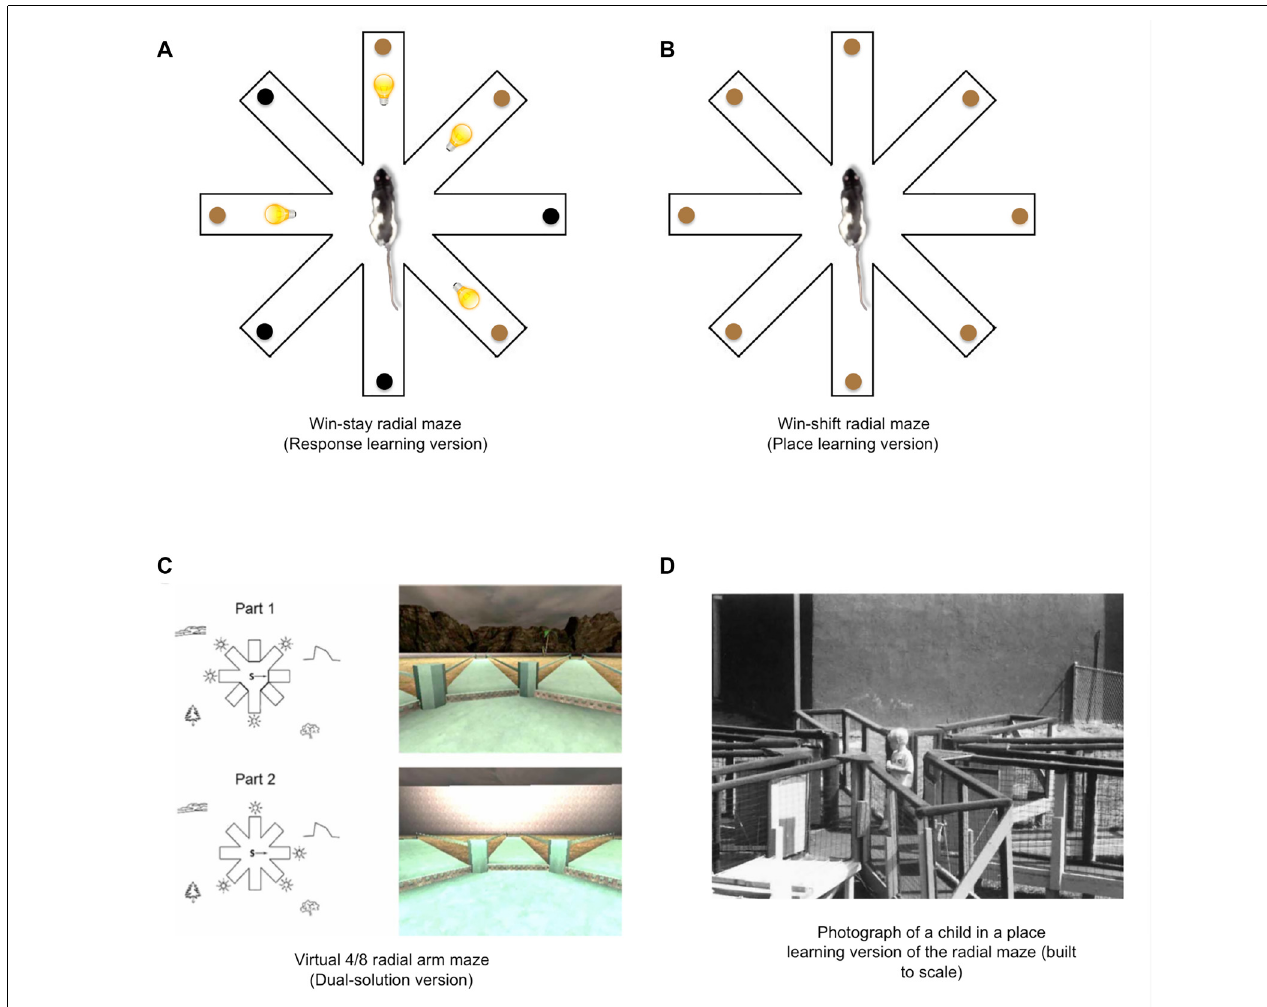
FIGURE 5 | Place and response learning in the eight-arm radial maze. (A) In the “win-stay” radial maze task, light cues signal whether food is available at the end of each arm. This task promotes S-R response learning to the extent that the light cues (S) become associated with approach behavior (R). (B) In the win-shift radial maze, a rat must employ extra-maze spatial cues to locate food and avoid re-entries into arms in which food was already retrieved, thus promoting the use of place learning. (C) A virtual 4/8 dual-solution version of the radial maze may be employed to examine the relative use of place and response learning in human subjects. Each trial of this task is divided into two parts (Part 1 and Part 2). During Part 1, four of the eight arms are blocked with a wall, and the participant is instructed to enter the four open arms and retrieve hidden reward objects. During Part 2, all of the arms are open, and the participant is instructed to retrieve the remaining reward objects from the arms that were previously blocked. To avoid arm re-entries, the participants may employ a place learning strategy (i.e., refer to extra-maze spatial cues to guide behavior to the correct arms) or a response learning strategy (i.e., memorizing a series of egocentric responses leading to the correct arms). During a subsequent probe trial, the extra-maze spatial cues are blocked from view, preventing the use of a place strategy. Therefore, more errors during this probe trial suggest the use of a place strategy, whereas fewer errors suggest the use of a response strategy (images from Bohbot et al., 2012). (D) A 4-year-old child searches for rewards in a place learning version of the eight-arm radial maze (image from Overman et al.,